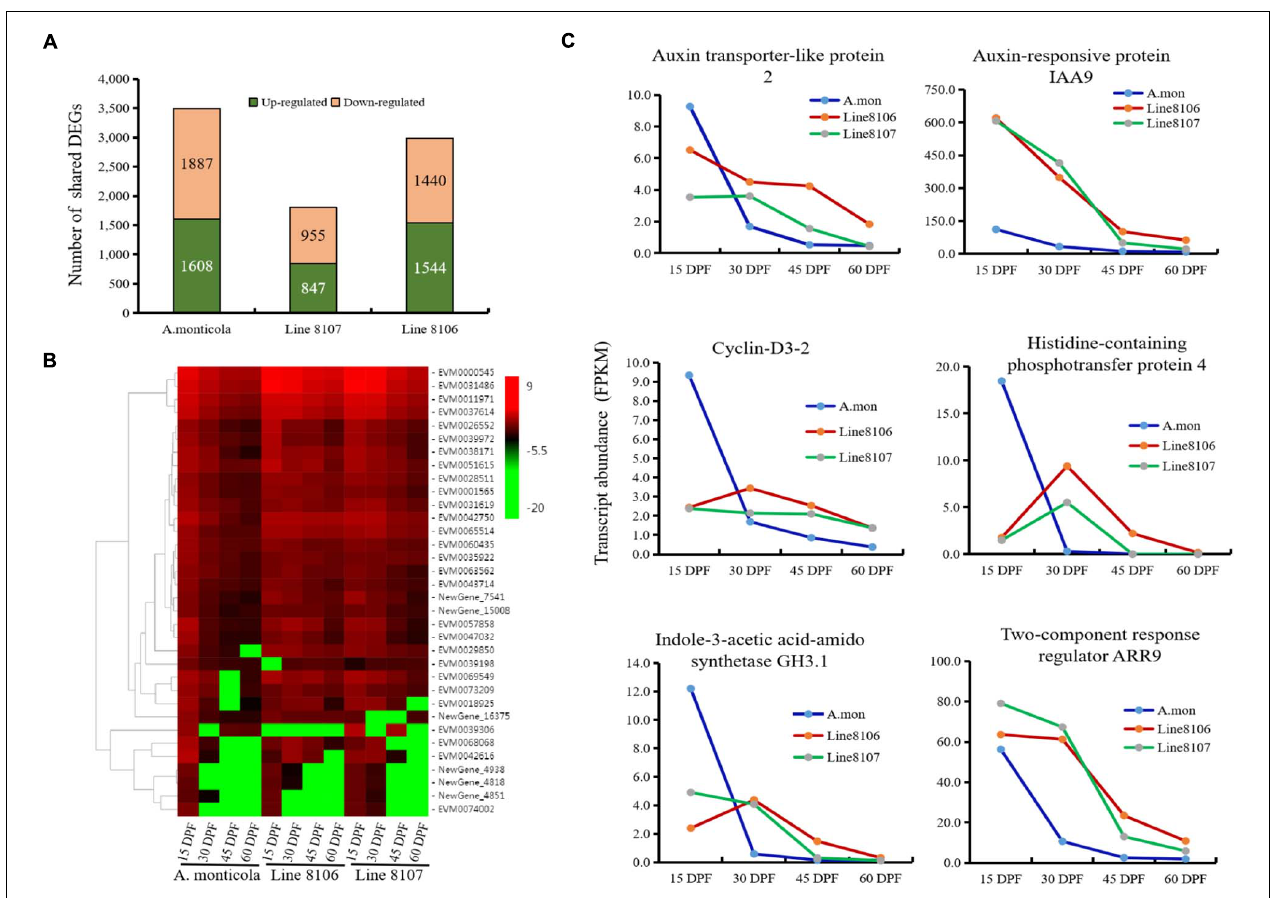
FIGURE 3 | Differential gene expression at the four seed developmental stages in each of the three peanut accessions. (A) The number of up- and down-regulated genes shared among three seed developmental stages (30, 45, and 60 DPF) for A. monticola , Line 8106, and Line 8107. (B) Heatmap showing the relative expression of plant hormone signaling pathway-related DEGs. (C) Expression levels of six representative genes from 15 to 60 DPF that are enriched in the plant hormone signaling